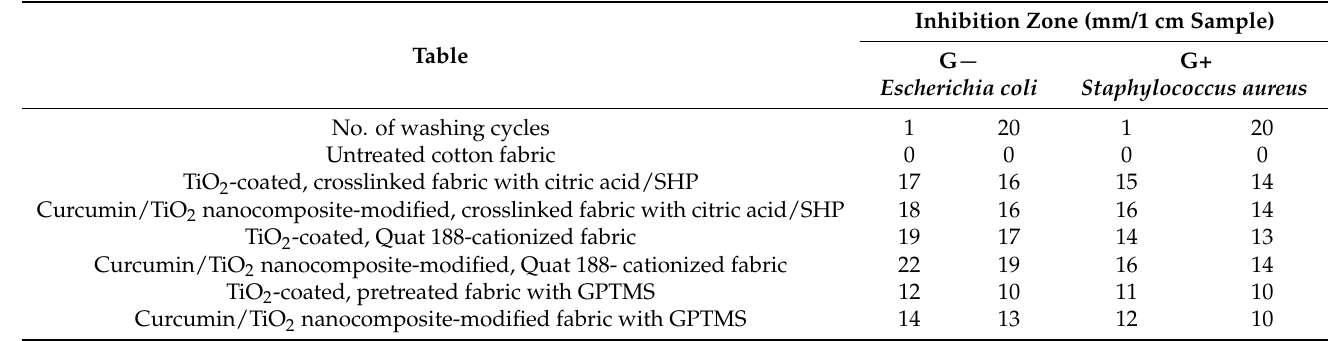
Table 1. Antibacterial activity and durability properties.